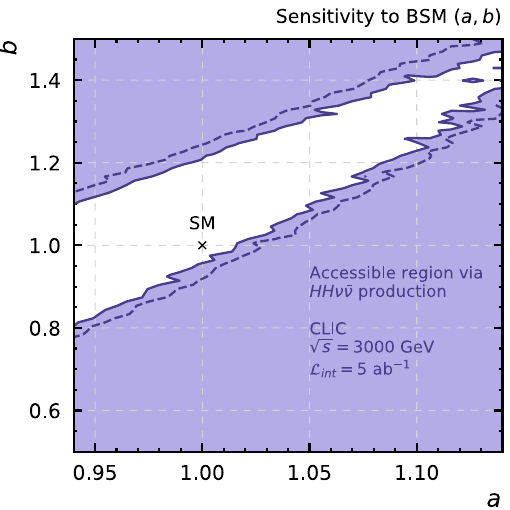
= 5 ab − 1 (right panel). The criterion of accesibility assumed here L √ int s = 1000 GeV is by means of the quantity R ≡ ( N BSM − N SM )/ √ s = 3000 GeV and purple area bounded by the solid (dashed) contourline for R ≥ 5 ( 10